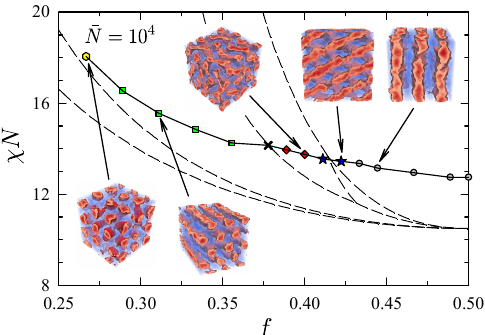
Figure 7. Order-disorder transitions for diblock copolymer melts at ¯ N = 10 4 . The different symme- tries of the ordered phases are denoted by circles (lamellar), stars (Fddd), diamonds (gyroid), squares (cylindrical), and hexagons (spherical). The cross marks an ODT for which the relative stability of the cylindrical and gyroid phases was indistinguishable. For comparison purposes, the SCFT phase diagram [21] is overlaid with dashed curves. Adapted from Ref.